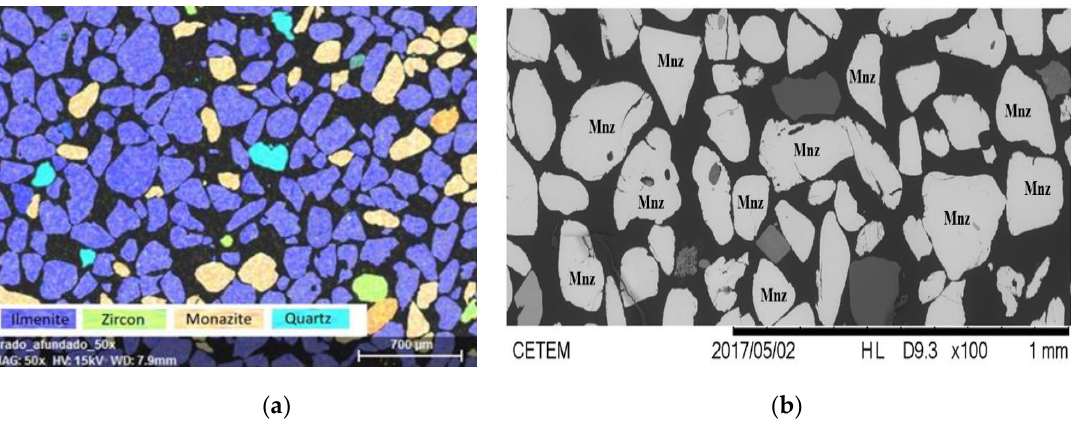
Figure 7. SEM image mapping of PA sink fraction ( a ) and SEM image of sink fraction retained at 1.3 T ( b ).